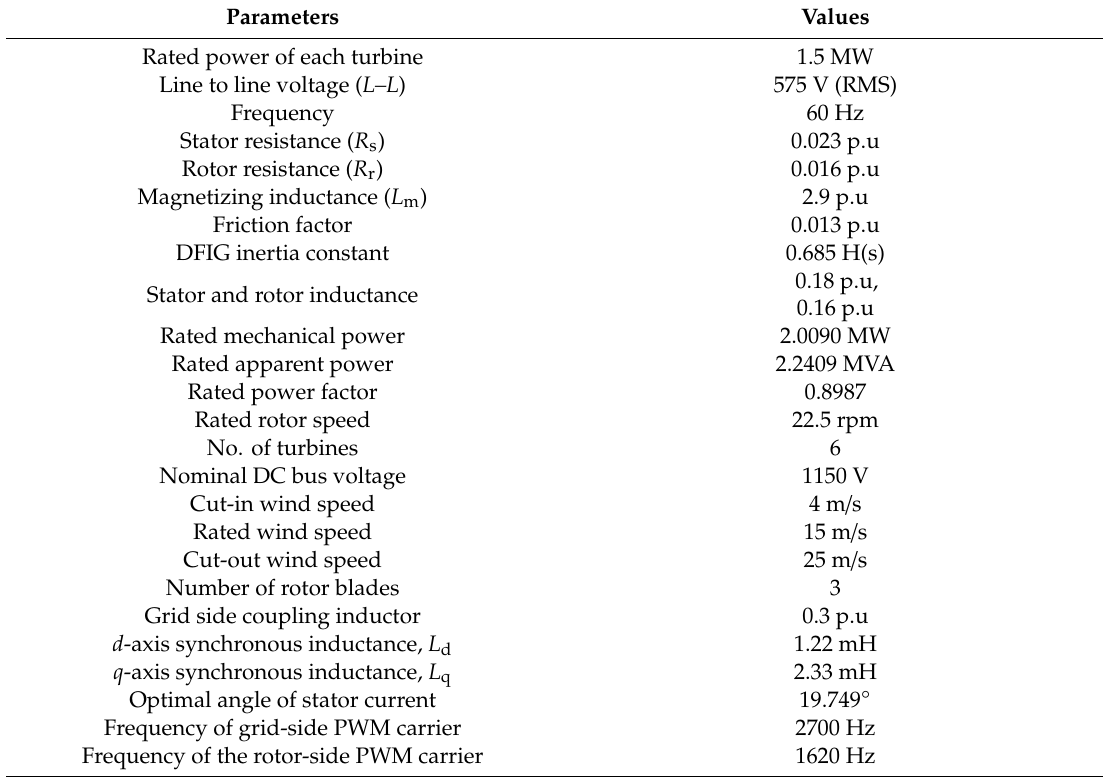
Table A1. Simulation Model Parameters of DFIG-Based Wind